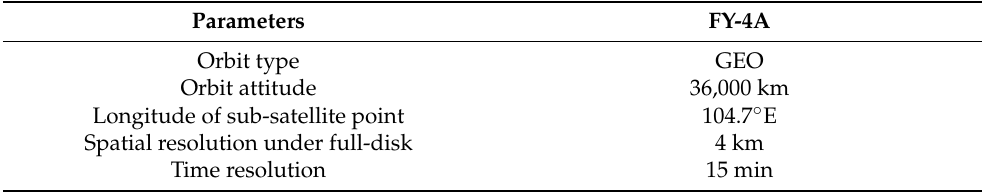
Table 2. Main parameters of FY-4A satellite.